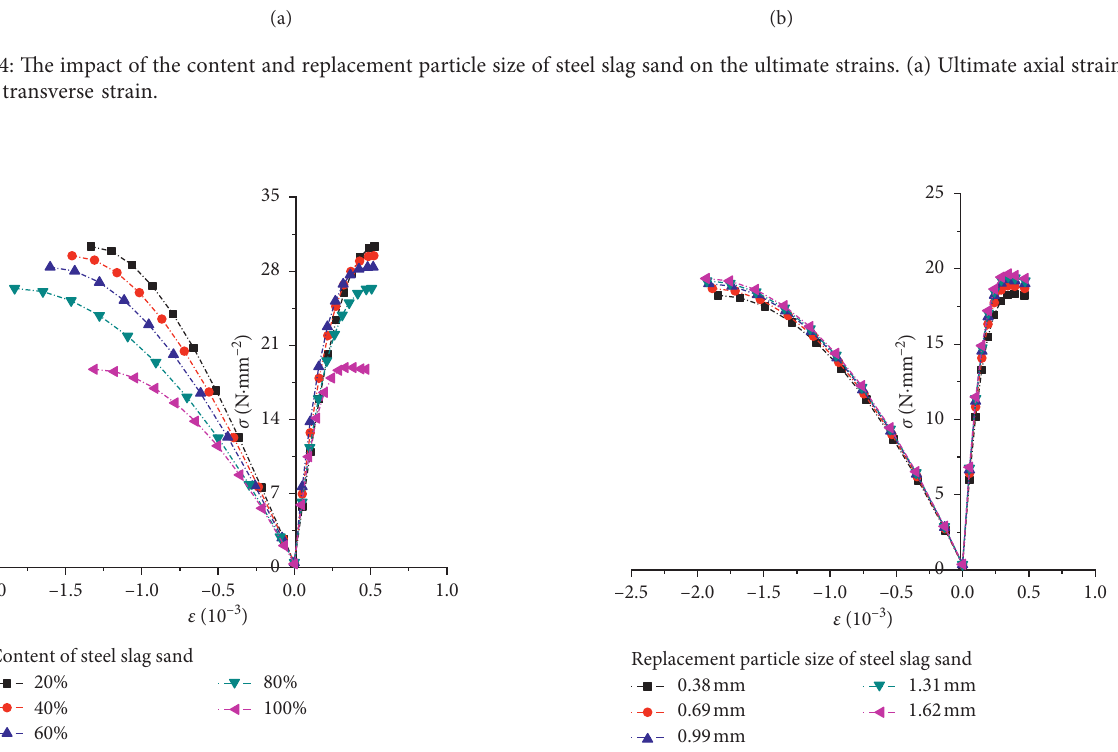
Figure 26: The impact of the replacement particle size of steel slag sand on the stress-strain